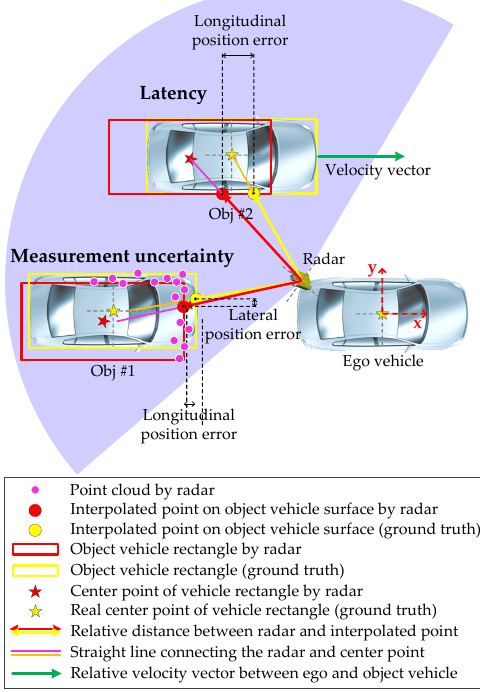
Figure 1. Example of object vehicle estimation by radar: the measurement uncertainty occurs due to insufficient point cloud and classification errors. This error occurs because the radar estimation algorithm (e.g., point cloud clustering, segmentation, single sensor tracking, multilateration, clas- sification, and filtering) can only estimate an object vehicle’s size with a virtual polygon box with partial information [7,8,14,35]. Furthermore, the latency that causes position errors occurs due to the tracking algorithm of a commercial radar. The error caused by the latency becomes larger depending on the relative